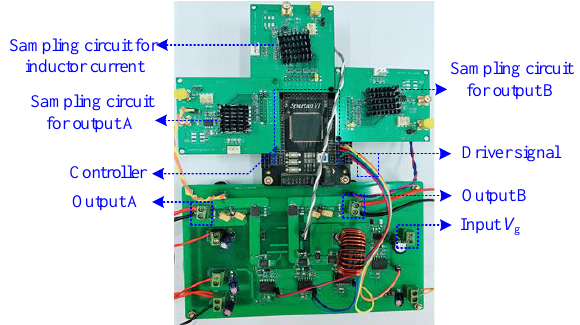
Figure 10. Photograph of experimental prototype.